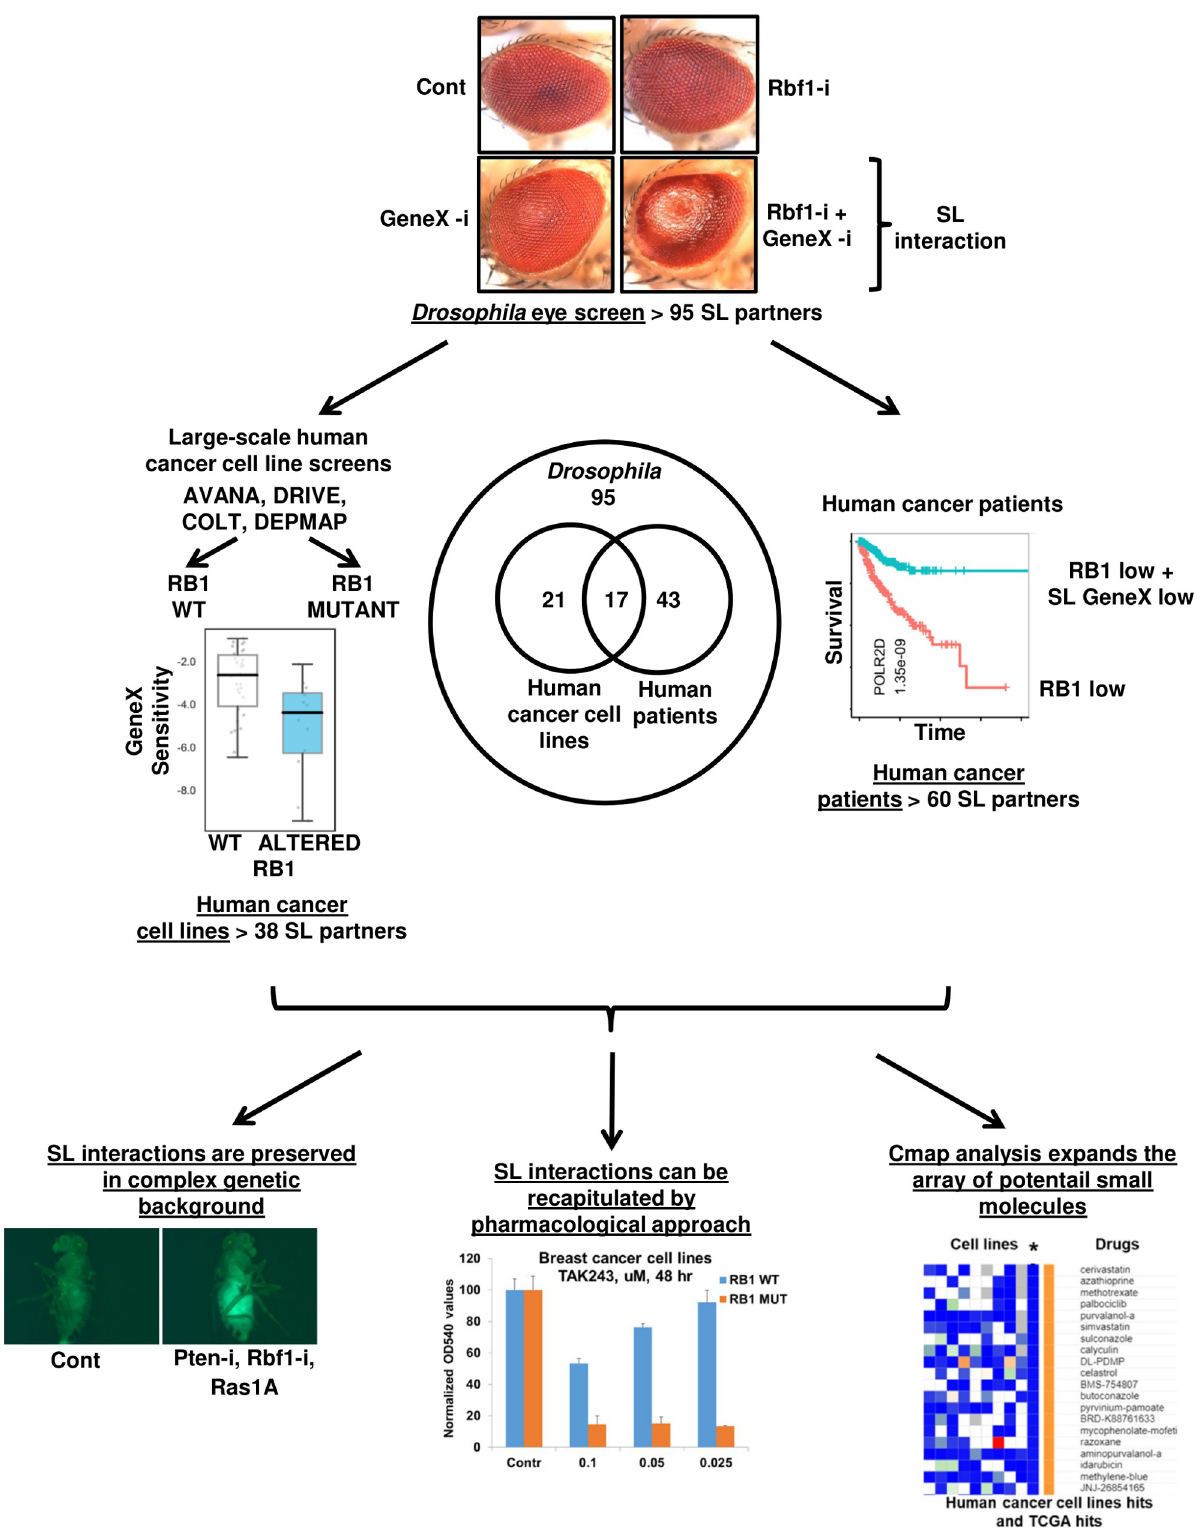
Fig 7. Overview of the findings presented in this study.